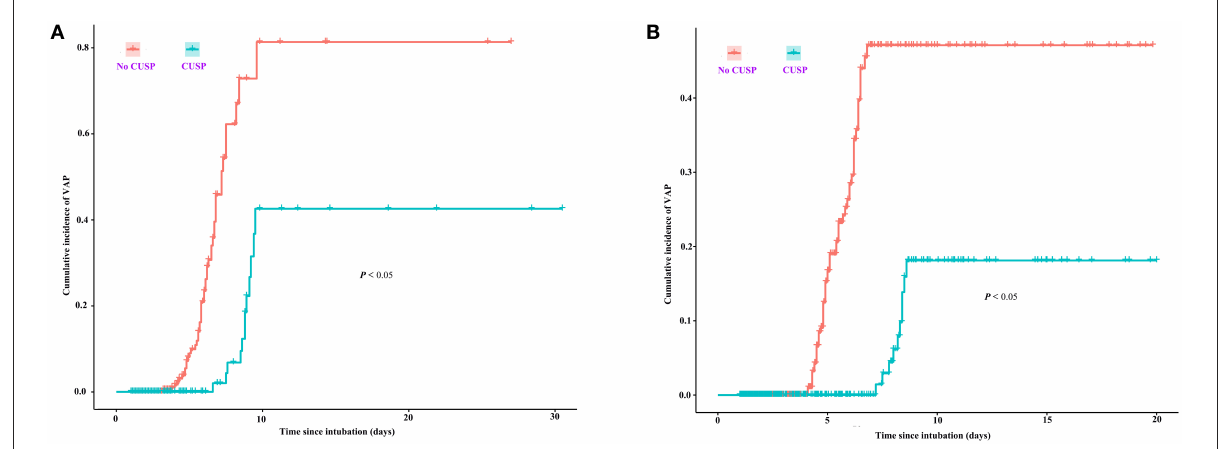
FIGURE2 Cumulative proportion curves showed that the VAP incidence in the no CUSP group was continuously distributed at the significantly higher side compared to the CUSP group in both TICU (A) and SICU (B) settings. The asterisks indicate a statistical significance, P -value (* P < 0.05; ** P < 0.01; *** P < 0.001). TICU, transplantation intensive care unit; SICU, surgical intensive care